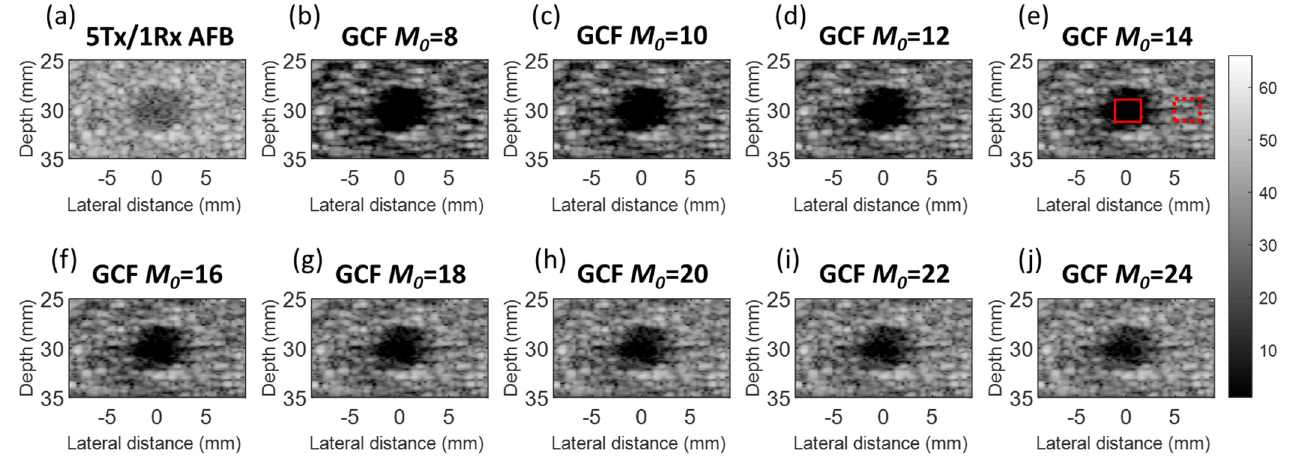
Figure 2. Images of an anechoic cyst over a 65-dB dynamic range. ( a ) 5 Tx/1 Rx AFB. ( b ) 5 Tx/1 Rx GCF with M 0 = 8. ( c ) M 0 = 10. ( d ) M 0 = 12. ( e ) M 0 = 14. ( f ) M 0 = 16. ( g ) M 0 = 18. ( h ) M 0 = 20. ( i ) M 0 = 22. ( j ) M 0 = 24.